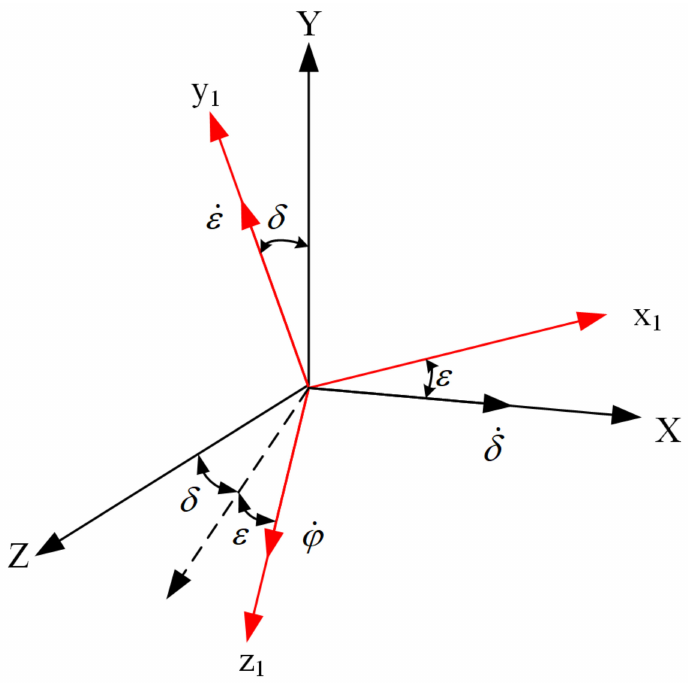
Figure 1. Reference frames.